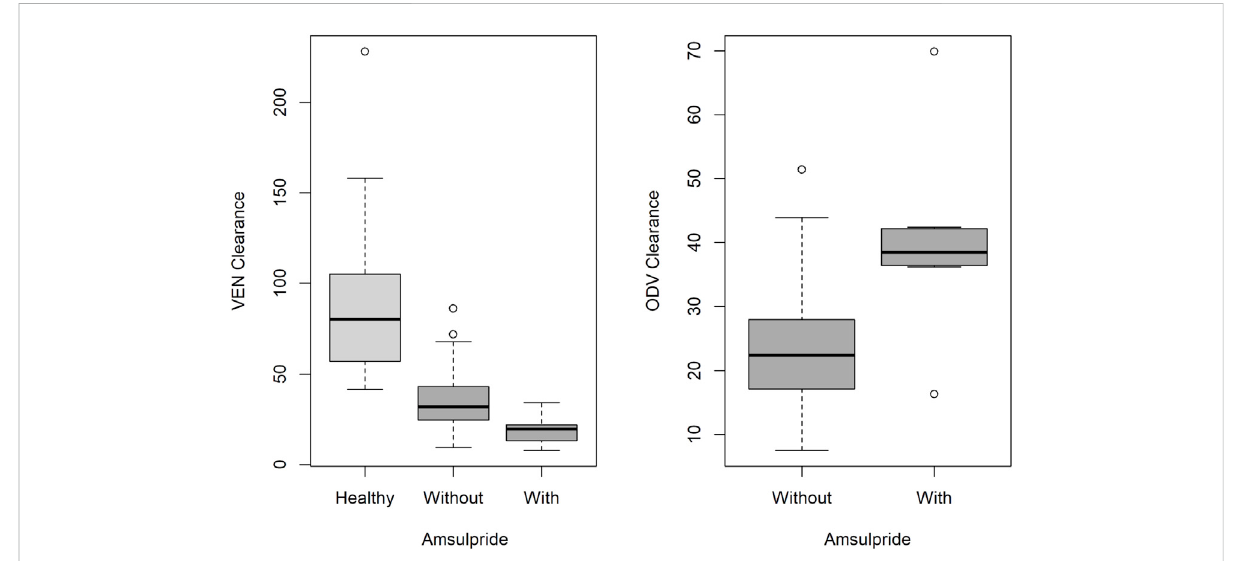
FIGURE 3 BoxplotwiththemedianandinterquartilerangeoftheclearanceofVEN(left)andODV(right)accordingtohealthstatusandconcomitantuseof amisulpride. Box with light grey represents healthy subjects, and box with dark grey represents patients.